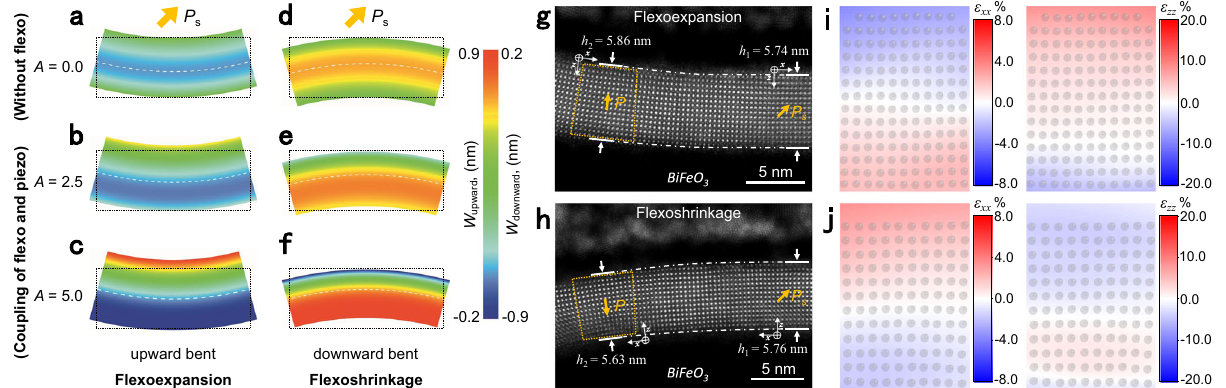
Fig.4|Flexoexpansionand fl exoshrinkageeffectsinpiezoelectricmembranes. a – f Simulated bending deformation of ferroelectric membranes (5nm thickness) with different bending expansion coef fi cients A =0.0 ( a , d ), 2.5 ( b , e ), and 5.0 ( c , f ) when bent upward ( a – c ) and downward ( d – f ), given that the out-of-plane sponta- neous polarization (yellow arrow) points upward. g , h The fl exoexpansion and fl exoshrinkage effects observed in upward ( g ) and downward ( h ) bent BFO,